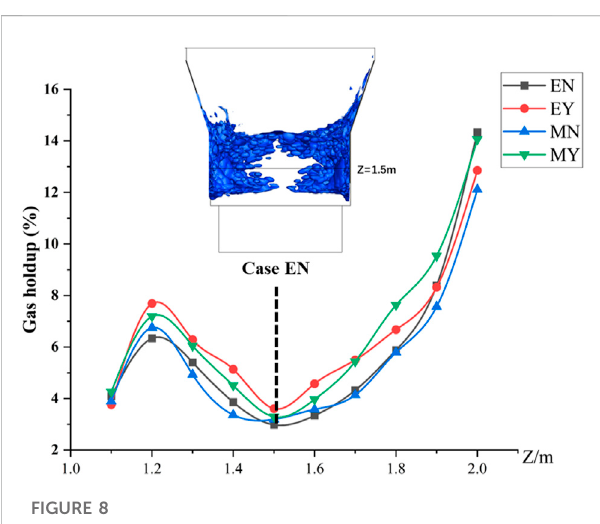
FIGURE 8 Variation curve of gas phase volume fraction along furnace height at 3 s under four